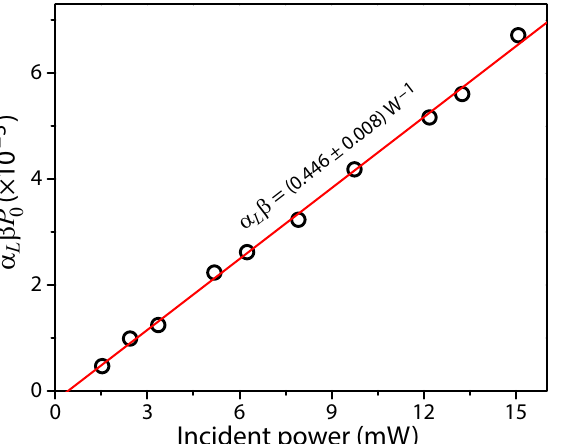
Figure 5. The dimensionless amplitude of the model α L β P 0 shows a linear dependence with the incident pump power referenced by a calibrated Ophir PD300 photodiode